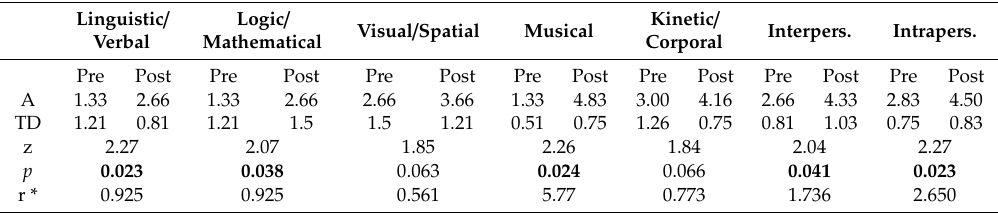
Table 3. Averages (A), typical deviations (TD), test results by Wilcoxon (Z), significance ( p ), and value of “Average Standardized Exchange Rate” (dMR) (r) of the total number of students in the pre-test and post-test in the Seven Intelligences